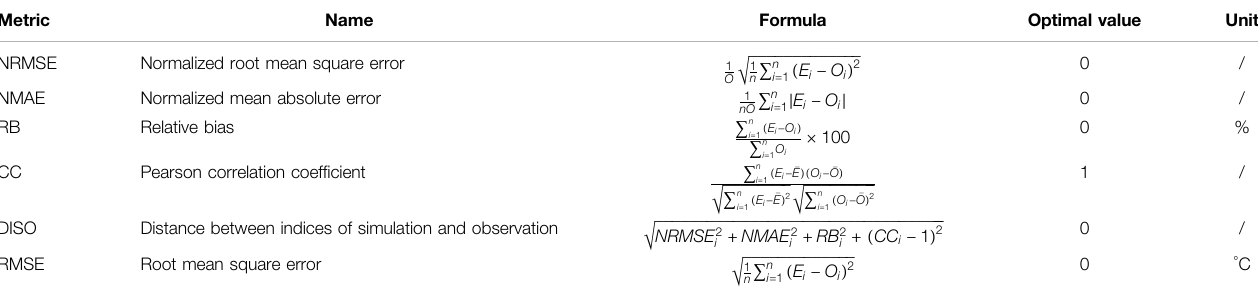
TABLE 4 | Evaluation criteria used in this study.